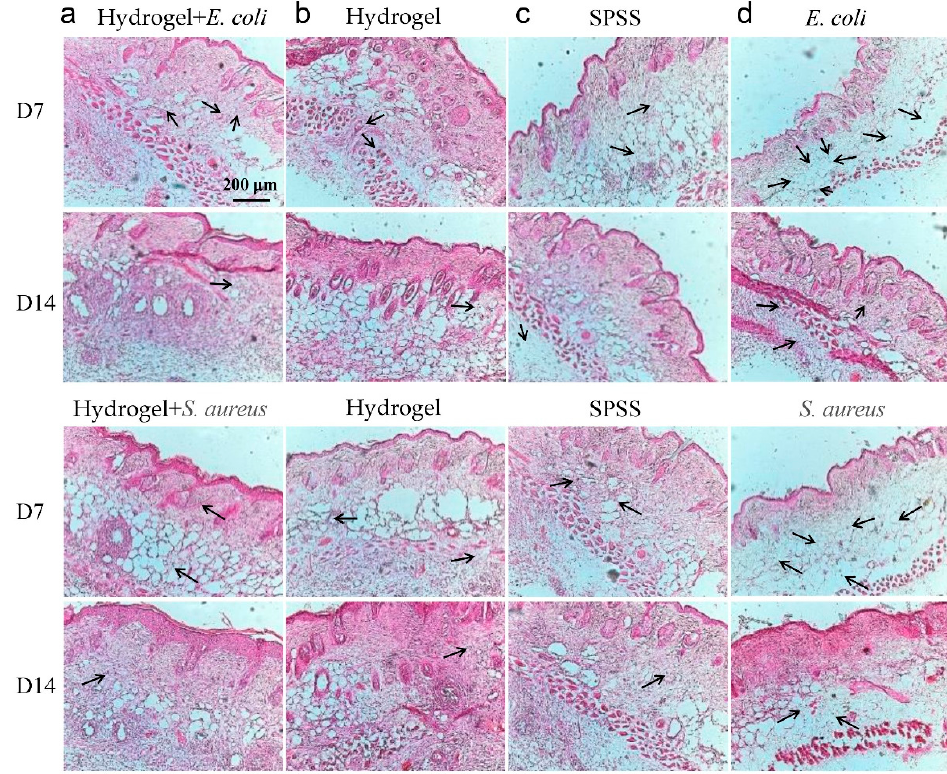
Figure 6. Mice skin sections stained with H&E on days 7 and 14 of ( a ) Hydrogel + bacteria; ( b ) Hydrogel-only; ( c ) SPSS; ( d ) Bacteria-only. (black arrows indicate inflammatory cells).